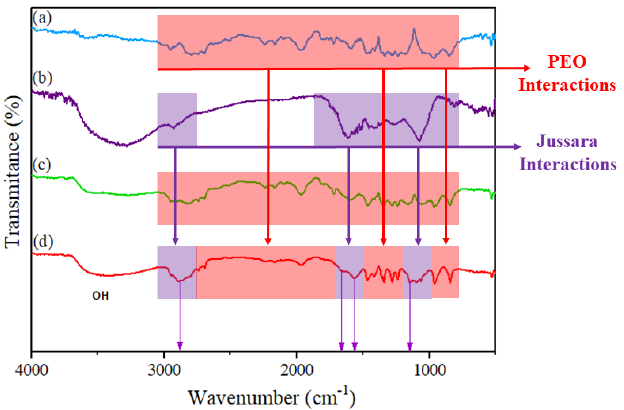
Figure 6. FTIR spectra: ( a ) sample 5 (PEO 6%), ( b ) jussara pulp, ( c ) sample composed by PEO 6% and jussara (uniaxial electrospinning), and ( d ) sample composed by PEO 6% and jussara (coaxial electrospinning), at room temperature.